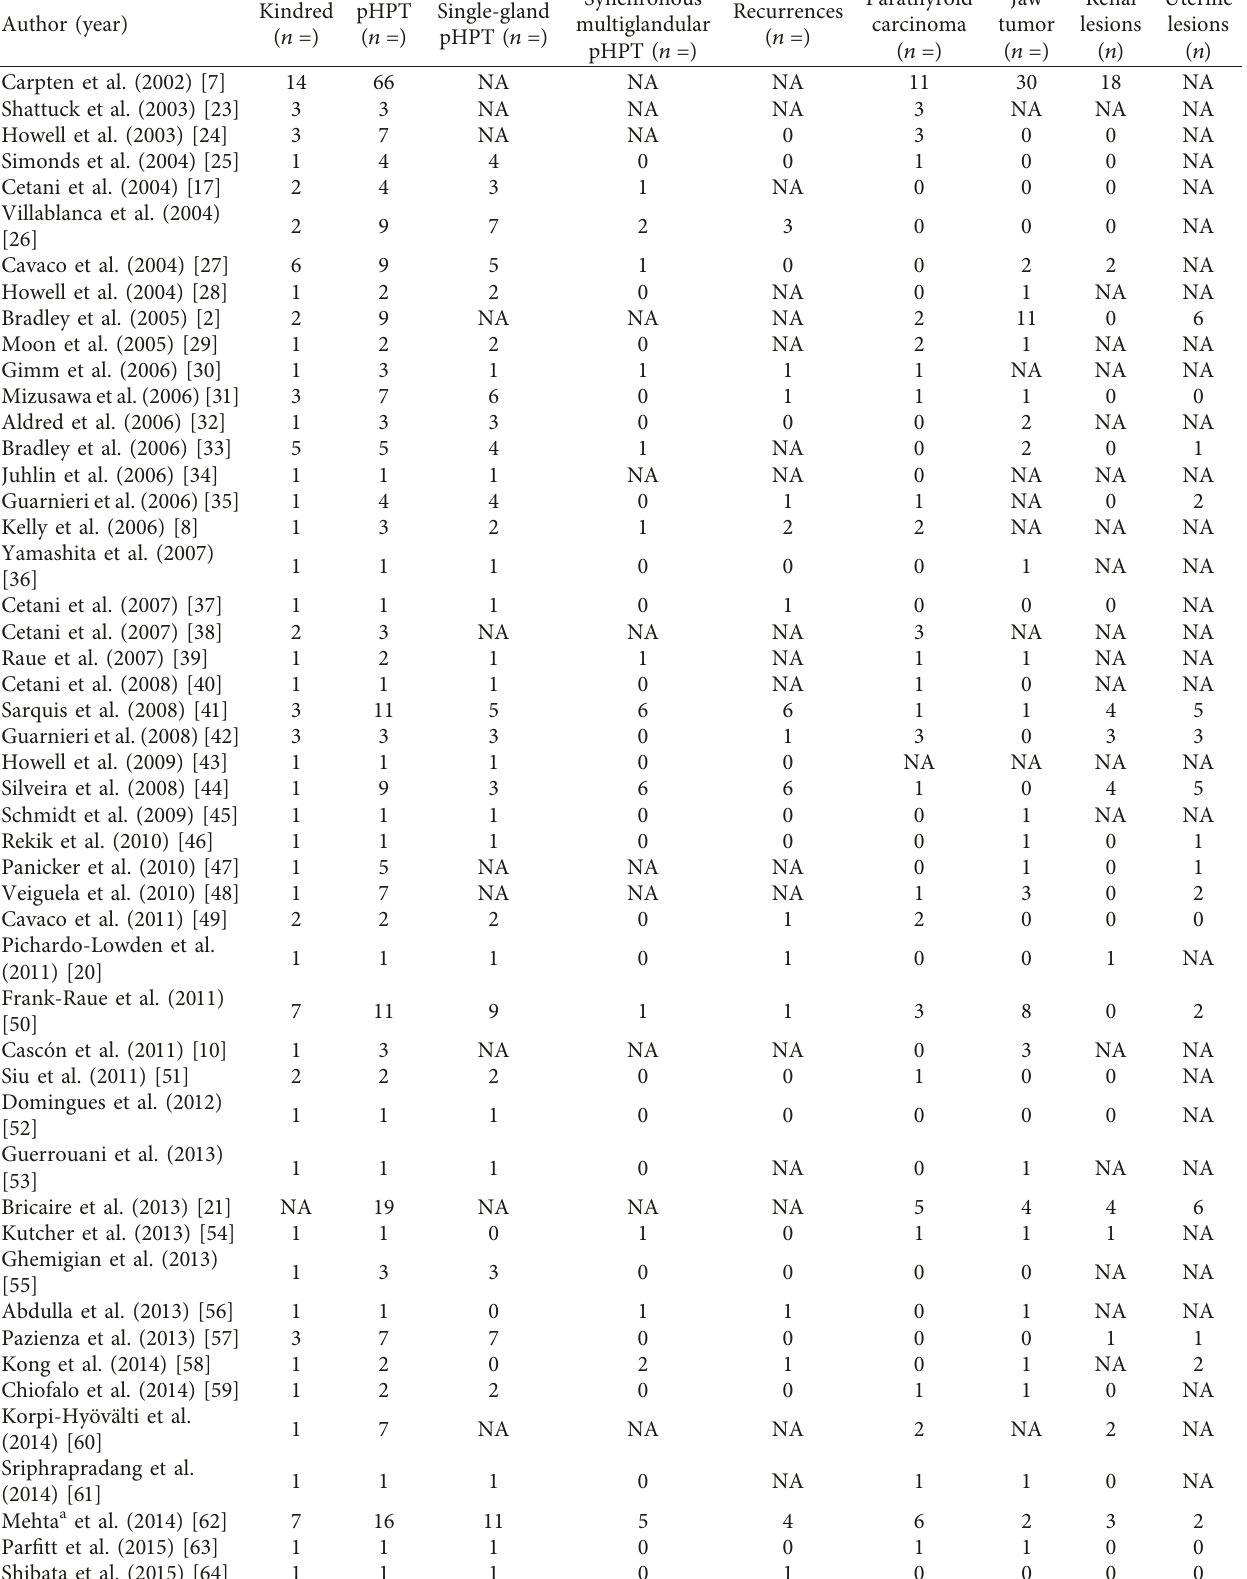
Table 1: Review of the literature focusing on HPT-JT